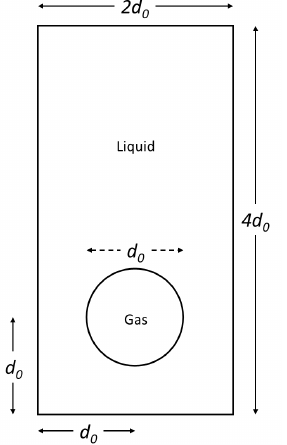
Figure A1. Physical domain and initial configuration for a verification test case. To define the physical properties of fluids, the diameter d 0 , velocity U g = time t 0 = d 0 / U g are the references scale for length, velocity, and time, respectively, and g is the acceleration of gravity. The subscripts l and g correspond to the liquid and gas phases, respectively; the Reynolds and Eötvös numbers are defined as Re = ρ l U g d 0 / µ l d 0 / σ , respectively. The physical parameters and dimensionless numbers (in and Eo = ρ l U 2 g terms of the defined references scales) defining the test case are given in Table A1. Table A1. Physical parameters and dimensionless numbers defining the test case.